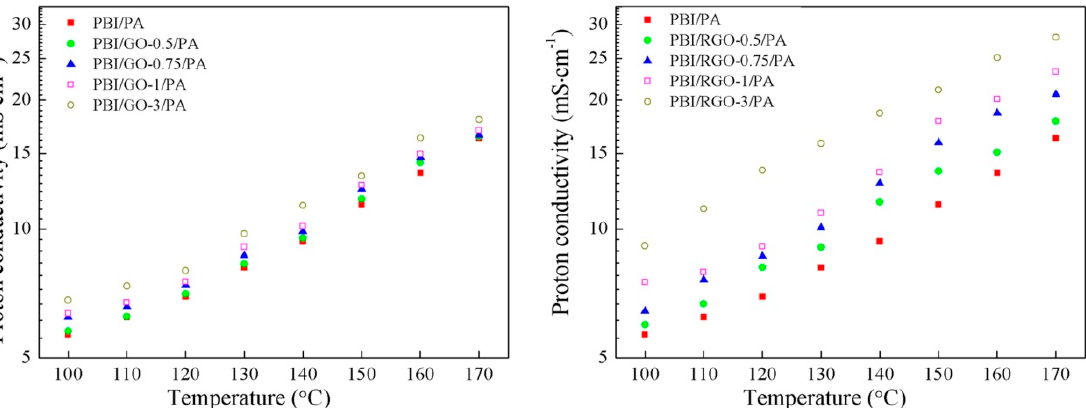
Figure 18. Temperature dependence of proton conductivity of PBI/GO/PA ( left ) and PBI/RGO/PA ( right ) membranes. Reproduced from [126 ] with permission of John Wiley and Sons.